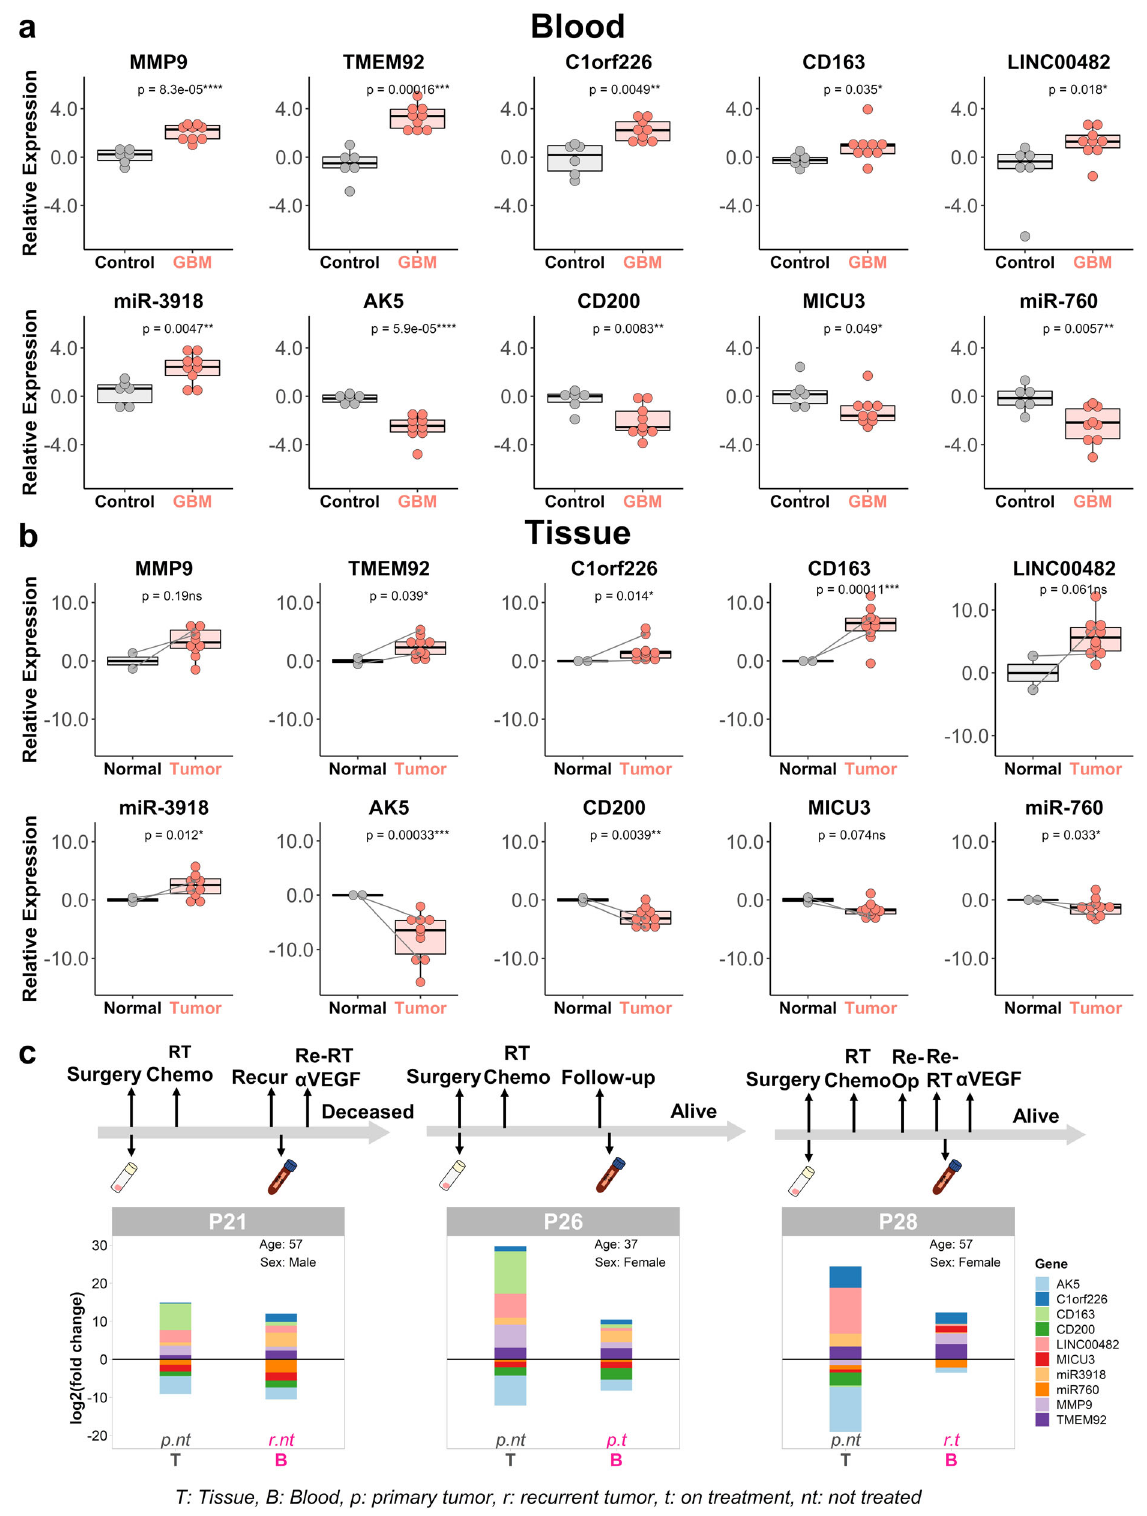
Fig. 5 RT-qPCR validation of selected genes and miRNAs in newly collected blood samples and tissue samples. a , b Mean values of multiple PCR results from blood ( a ) and tissue ( b ) samples are shown in boxplots. Data for controls are shown with dots in gray, and data for GBMs are shown with dots in salmon. Box limits indicate the range of the central 50% of the data (from 75th to 25th quantiles) with the central line marking the median value. Comparisons (one-sided t -test): GBM vs. control ( a ) or tumor vs. normal ( b ). Data for samples from the same patient are connected by gray right arrow lines. c Expression of the GBM-Dx panel in the blood and tumor tissue of three GBM patients is shown in stacked bar plots. P GBM patient, Age age at blood draw, RT radiation therapy, Chemo chemotherapy, Re-RT reirradiation, Re-Op reoperation or reresection, α VEGF anti-VEGF/anti-angiogenetic therapy.